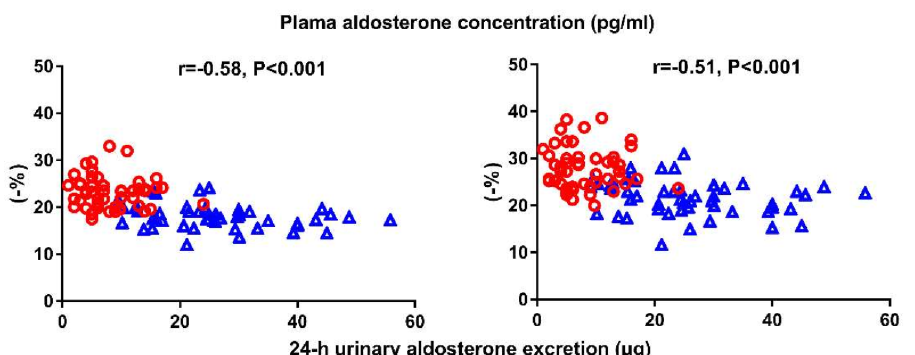
Figure 2. Correlation analyses of right ventricular four-chamber longitudinal strain (RV4CLS, left ) and right ventricular free wall longitudinal strain (RVFWLS, right ) with plasma aldosterone concen- tration ( upper ) and 24 h urinary aldosterone excretion ( lower ) in patients with primary aldosteronism (triangle) and those with primary hypertension (circle). The correlation coefficients and corresponding p values are given for all patients. Reproduced with permission from Chen YL, et al.